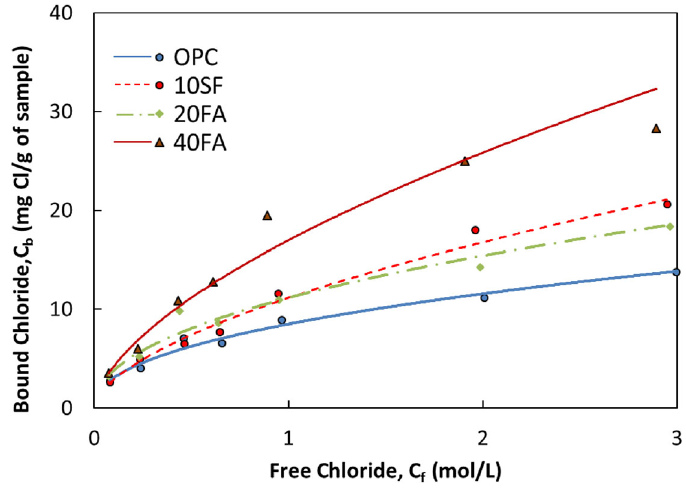
Fig. 3 Chloride binding isotherms of the cement pastes at 23 (cid:2) C.